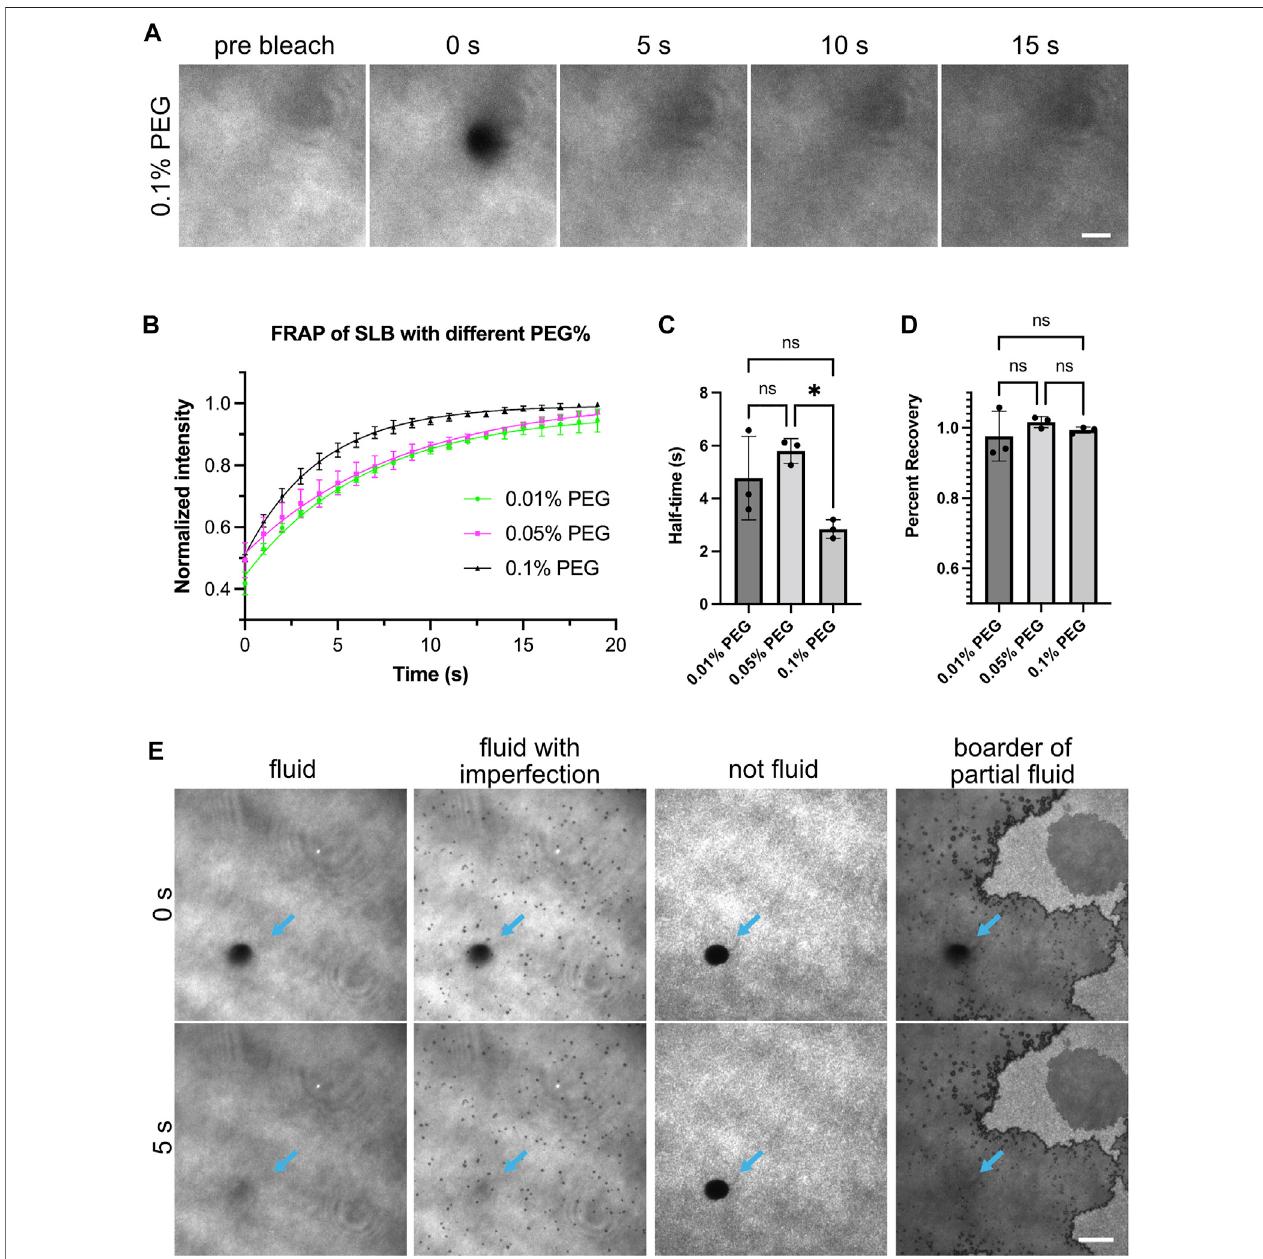
FIGURE 1 | Fluidity of supported lipid bilayers. (A) Example images showing fl uorescence recovery after photobleaching (FRAP) for lipid bilayers labeled by NBD- PC lipids. Bilayers imaged with Total Internal Re fl ection Fluorescence (TIRF) microscopy. This example bilayer contains 98% POPC, 2% Ni-NTA, 0.1% NBD-PC and 0.1% PEG5000-PE. Numbers above the images indicate seconds after photobleaching. A 5 µm-diameter region (outline can be seen in 0 s panel) is bleached with a 405 nm laser. Scale bar, 5 µm. (B) FRAP measurement of bilayer. Each point represents the mean ± standard deviation of three independent measurements. A curvecalculated fromasingleexponential fi tisoverlaid inthe graph. (C,D) Recovery halftime and percentage recovery calculated from thesingle exponential fi tforeach measurement. Statistical analysis is carried out through ordinary one-way ANOVA with Tukey ’ s multiple comparisons test, * indicates the difference is signi fi cant at p < 0.05. (E) Examples of common bilayer defects. Blue arrows indicate the photobleached area. Scale bar, 10 µm.